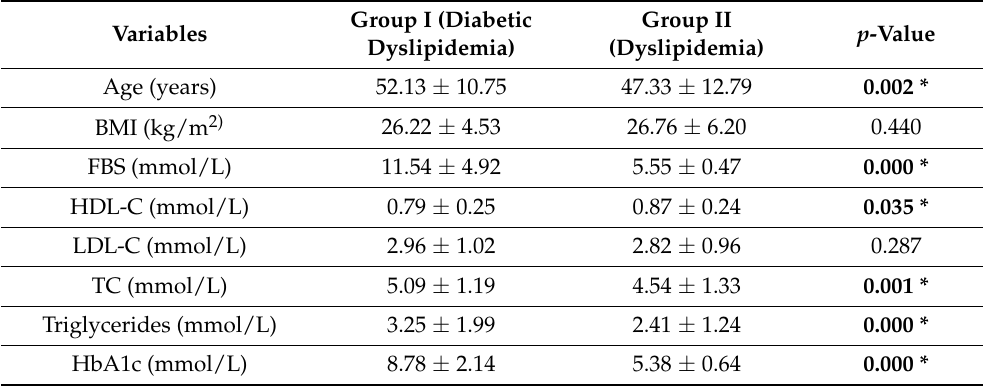
Table 1. Independent Samples t -test to compare the mean difference in data variables ( p -value ≤ 0.05).